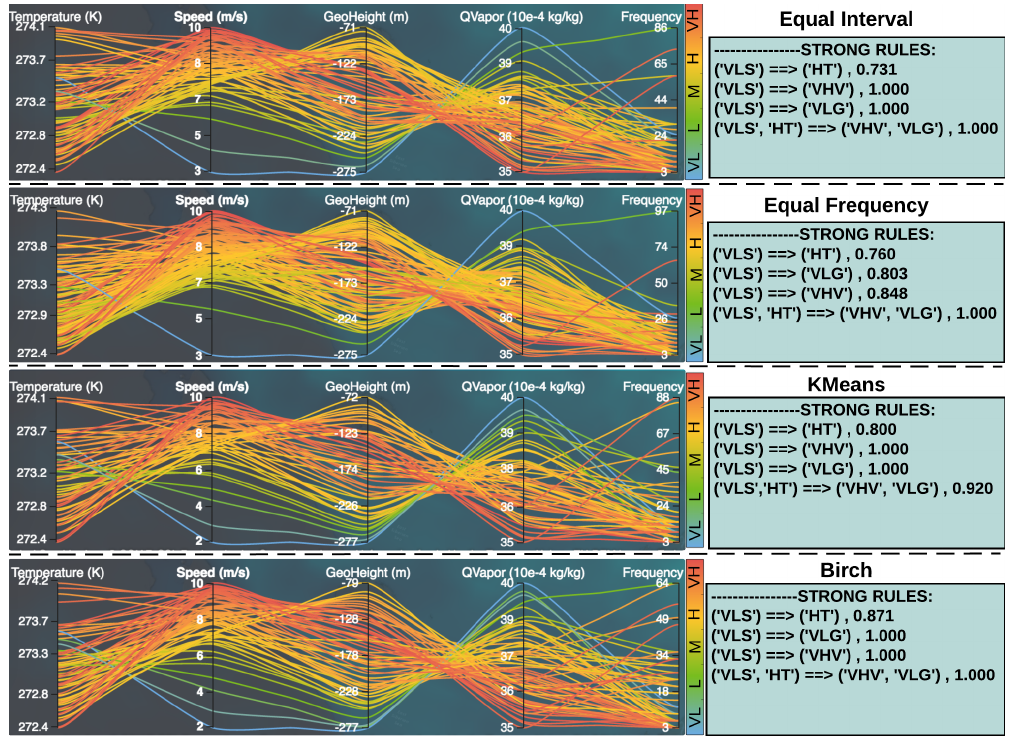
Figure 4. Data visualization and analysis outcome using four different category strategies. Top to bottom: equal interval, equal frequency, K -means and birch.